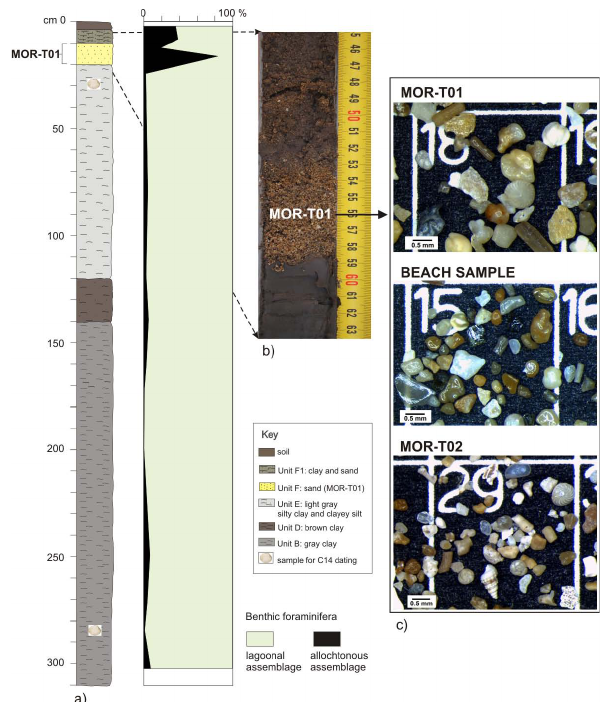
Fig. 7. (a) S51 core log coupled with a down core distribution of the benthic foraminifera assemblage; (b) core picture from 24cm to 6cm of depth showing the MOR-T01 sandy interval; (c) three examples of washed residues are illustrated: MOR-T01 from the S51-3 sample, MOR-T02 from S12-8 sample and the sand beach sample was collected on the